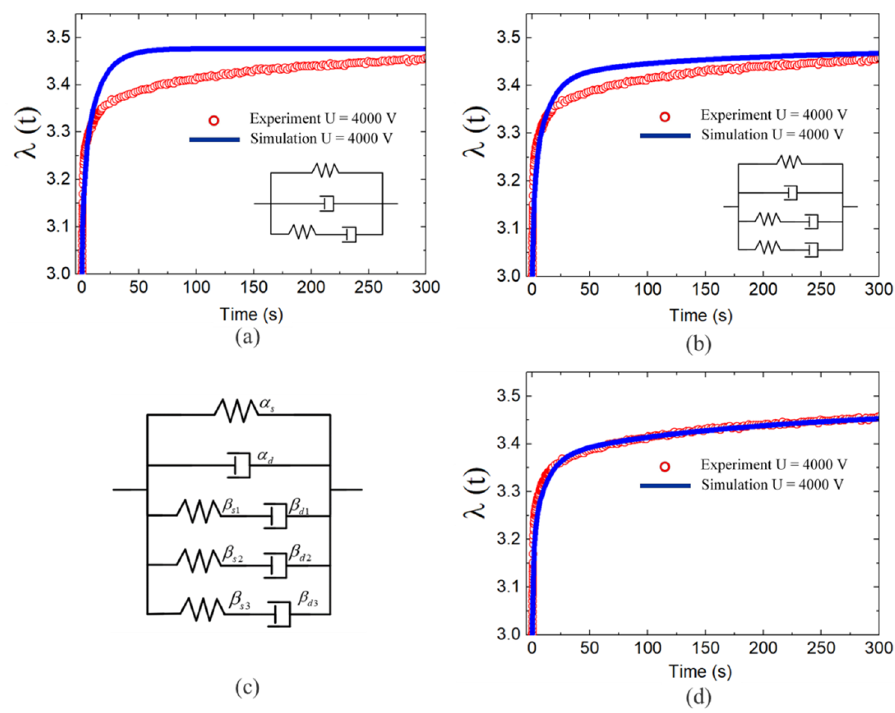
Figure 9. Step quantitative analysis of experimental and simulation results for DE membranes with different numbers of Maxwell units: ( a ) one-unit fitting, ( b ) two-unit fitting, ( c ) effective rheological model, and ( d ) effective three-unit fitting.